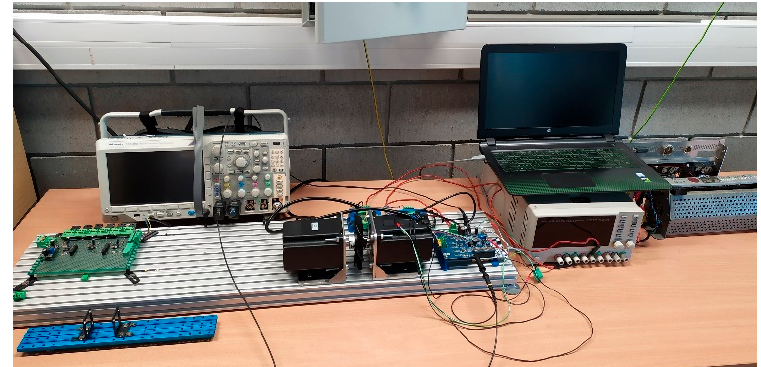
Figure 1. Test bench. Figure 2. Winding temperature sensor placement (red arrow). Table 1. Tested BLDC motor specifications.